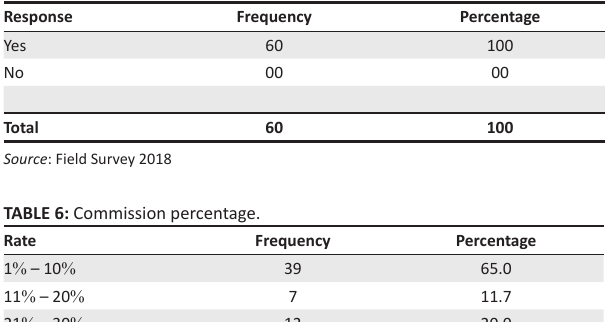
TABLE 3: Participants response towards the reward system at Ghana Commercial Bank.